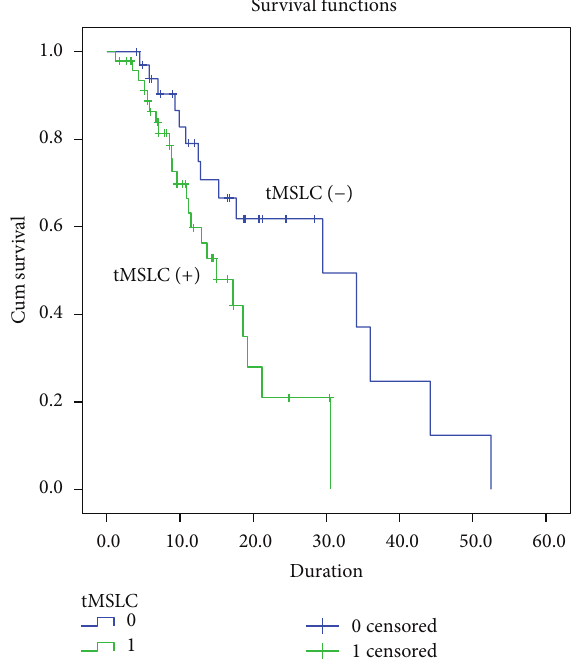
Figure 1: Kaplan-Meier estimates of overall survival according to tMSLCs isolation ( 𝑃 = 0.014 as calculated by the log-rank